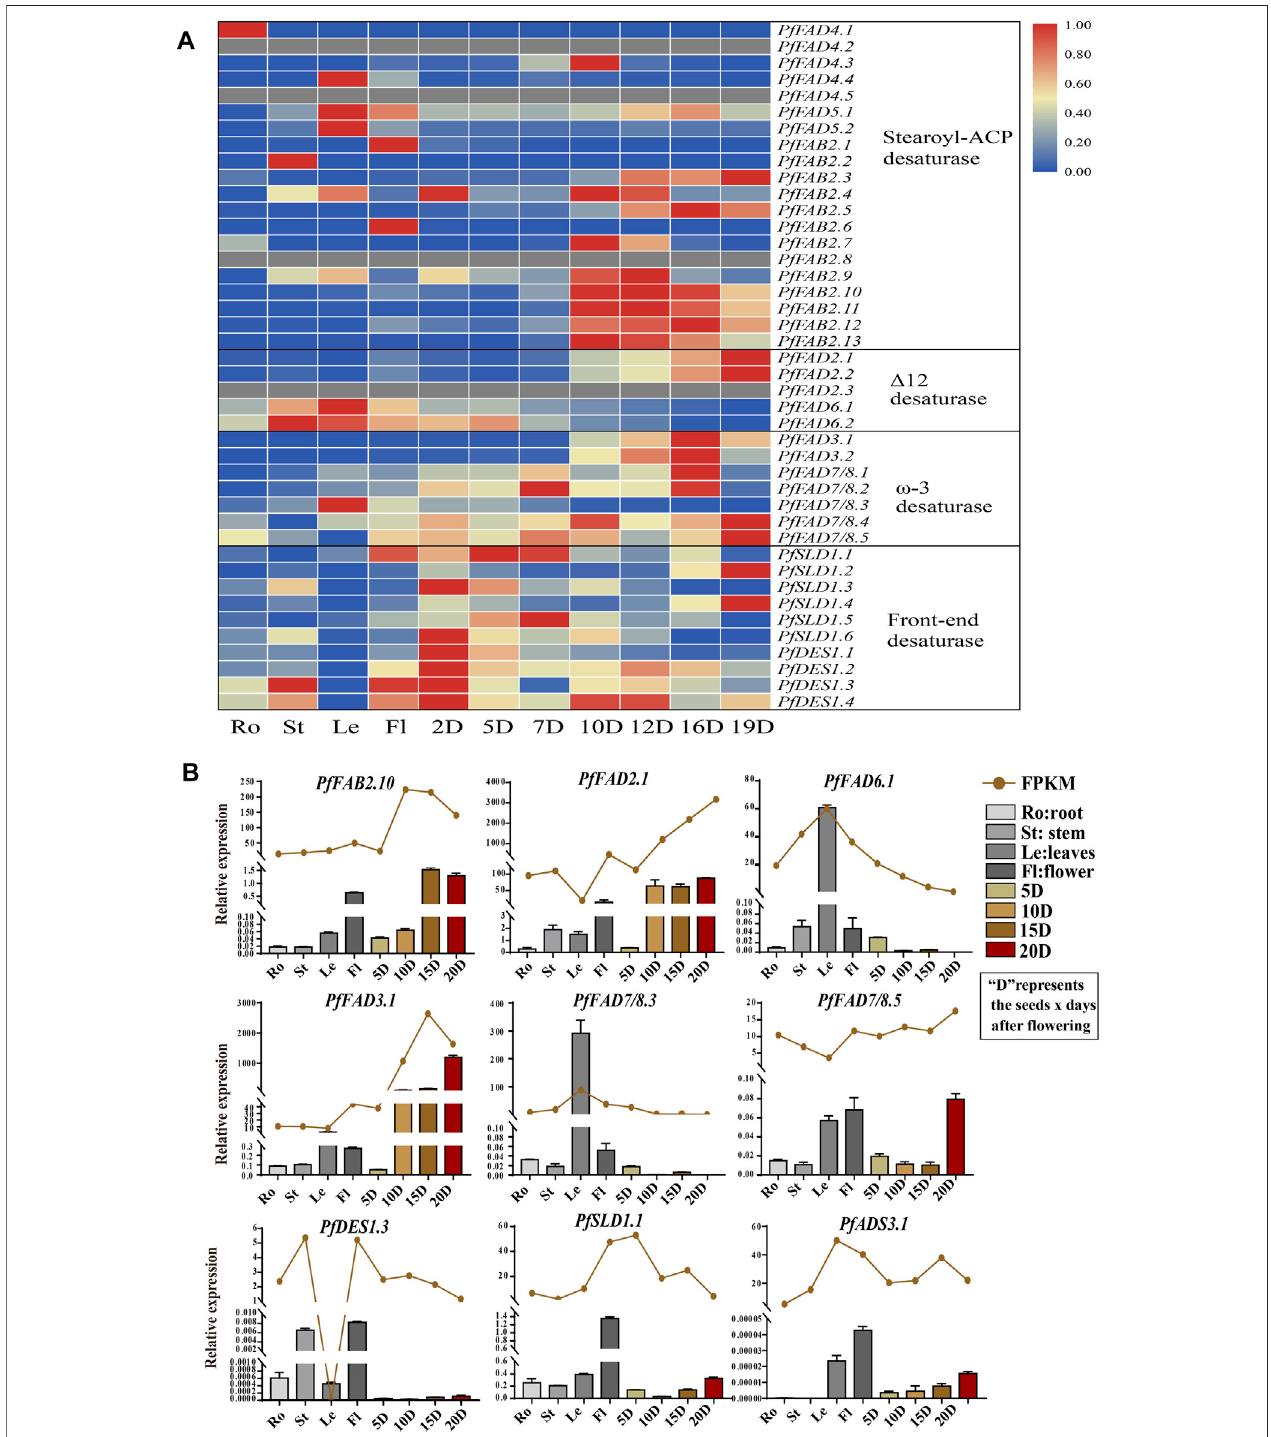
FIGURE3| Expressionpro fi lesof FAD genesin P.frutescens. (A) Expressionpatternsof PfFADs basedonfragmentsperkilobaseoftranscriptpermillionmapped reads(FPKM)fromperilla.Thecolorgradientblue – white – redindicateslowtohighlevelsofgeneexpression. (B) Relativeexpressionlevelsof PfFAD genesdeterminedby qRT-PCR and shown as FPKM. The perilla Actin gene was used as an internal control for normalization. Error bars represent SD from at least three biological replicates. Ro, roots; St, stems; Le, leaves; Fl, fl owers; 2D – 20D, seeds at 2 – 20 days after fl owering.